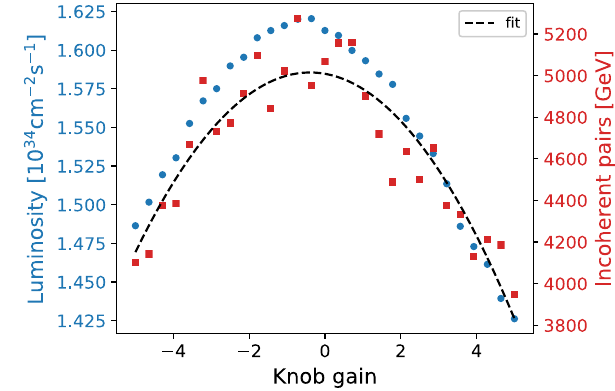
4. The distribution of electrons and positrons emitted in the forward direction of the electron main beam. Particles with the correct angles, and sufficient energy not to be deflected by the 4 T detector magnetic field, will end up in the BeamCal (marked with black lines). Positrons will be deflected by the opposing positron main beam, and, hence, more positrons than electrons end up in the BeamCal; the converse is true for the incoherent pairs emitted in the forward direction of the positron main